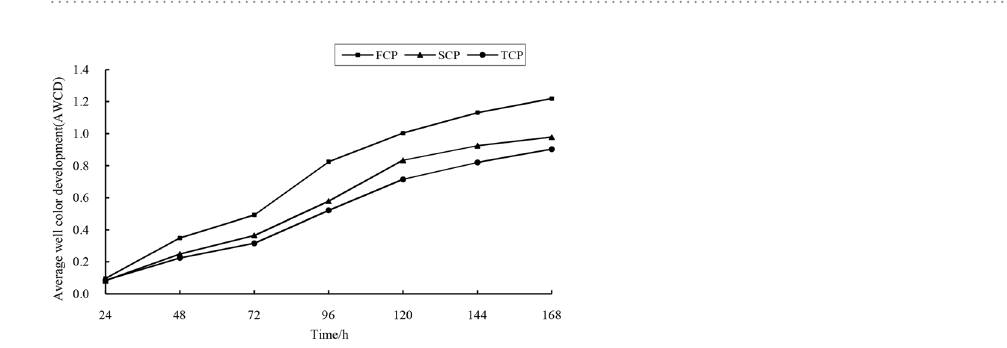
Figure 1. Principal components analysis (PCA) of three rotations plantations.